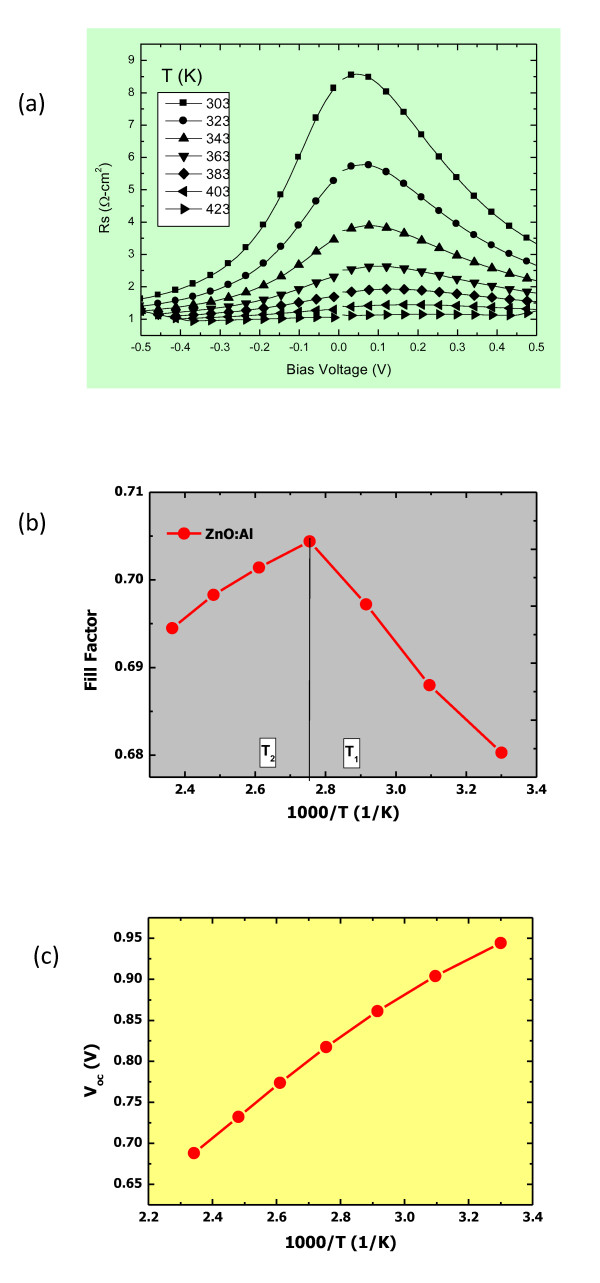
Variation of resistance (R TCO/p), FFs and Voc. (a) The bias voltage dependence of RTCO/punder various temperatures. (b) The temperature dependence of FFs for solar cell. (c) The temperature dependence of Voc for cells with the AZO as a TCO.